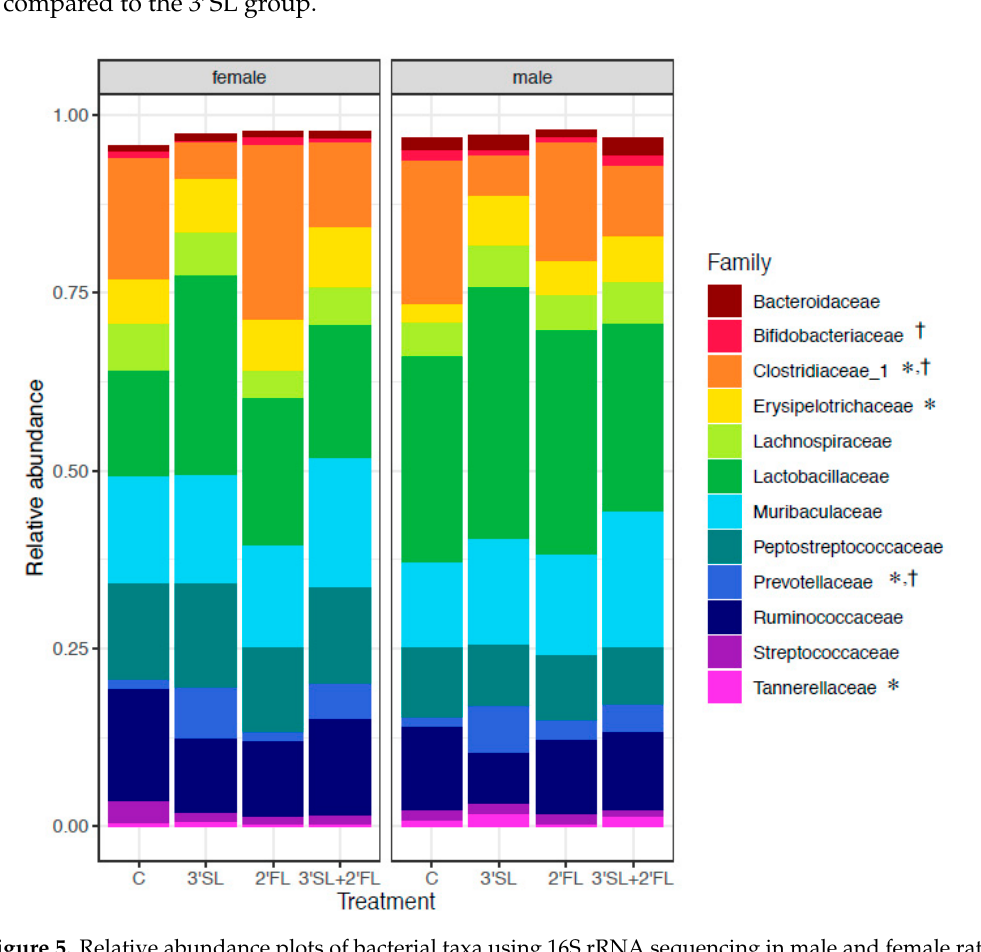
Figure 5. Relative abundance plots of bacterial taxa using 16S rRNA sequencing in male and female rat feces at 11 weeks of age. Taxa were identified to the taxonomic level of family using the Silva reference database. Control: AIN-93; 3’SL: AIN-93 + 3’sialyllactose; 2’FL: AIN-93 + 2’fucosyllactose; 3’SL + 2’FL: AIN-93 + 3’sialyllactose + 2’fucosyllactose. * p < 0.05 (males); † p < 0.05 (females).